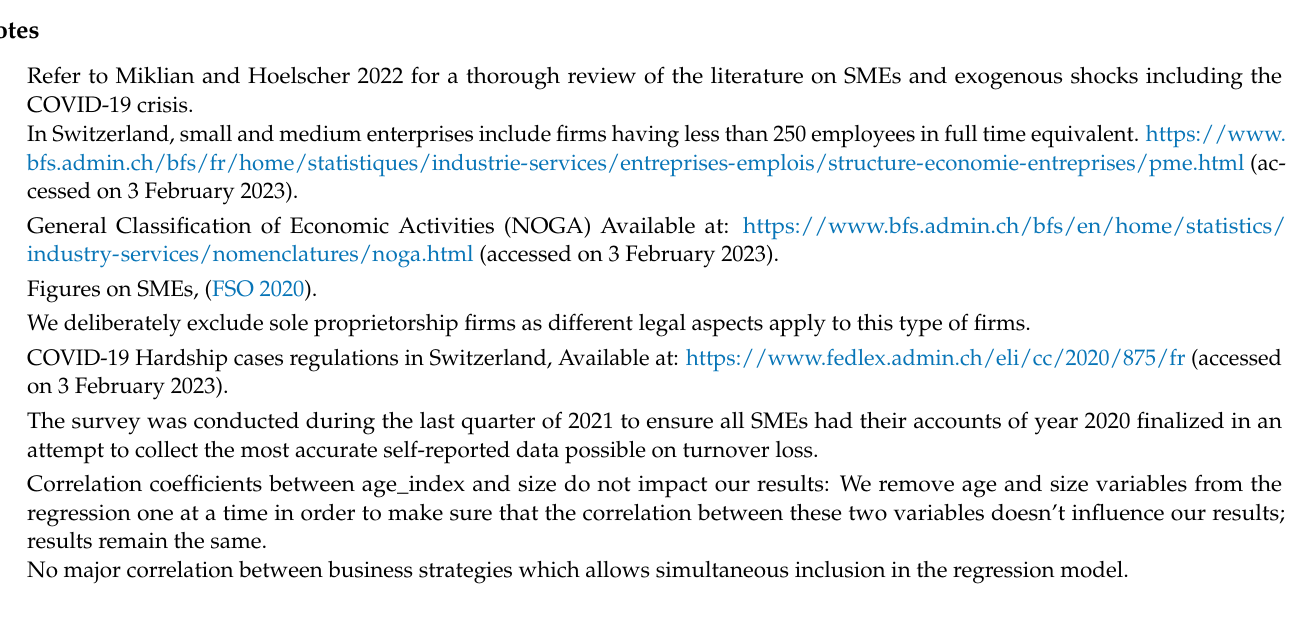
Figure A1. Marginal effects of remote work on turnover variation for different levels of remote work.